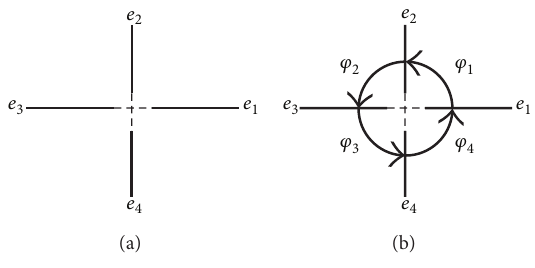
Figure 9: Elements for